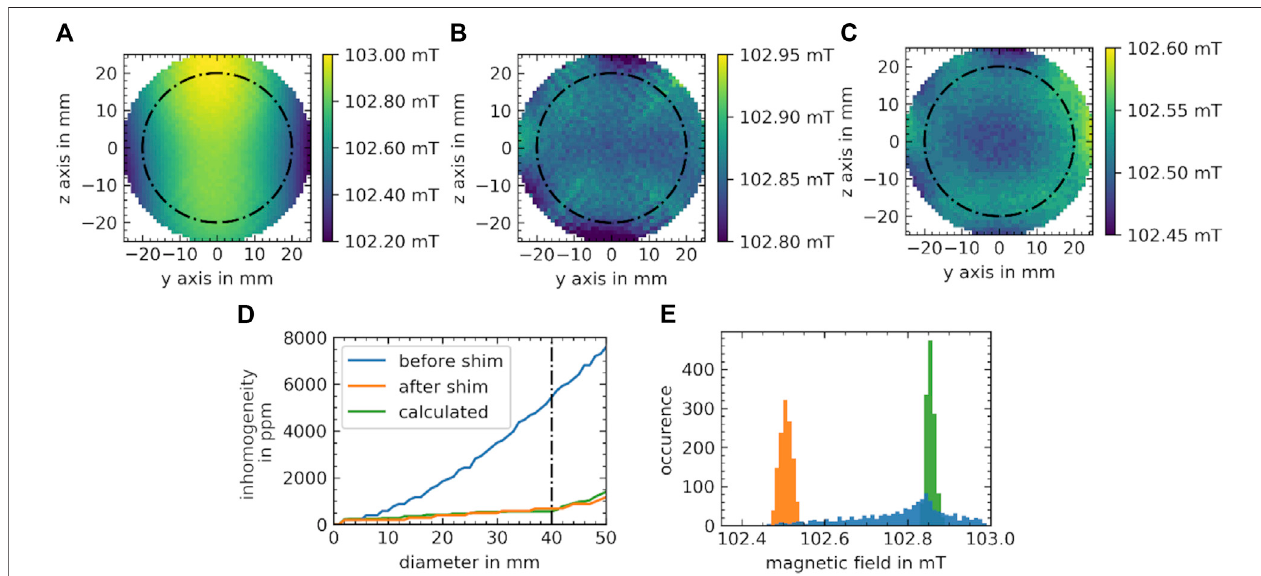
FIGURE 7 | Measured magnetic fi eld distributions before and after shimming on a two-dimensional target slice. (A) Measured fi eld distribution of the desktop MR magnet before shimming. (B) Predicted distribution calculated by the genetic algorithm with the dipole approximation. (C) Measurement after the implementation of the shim.Theblackdash-dottedlineindicatesthe4 cmtargetregion. (D) Fieldinhomogeneitiesoverdiameteroftheslicemeasuredbefore(blue)andaftertheshim(orange), together with the prediction of the shim, as calculated by the algorithm (green). (E) Occurrence of fi eld values measured before (blue) and after shimming (orange) and calculated (green) by the algorithm in the 4 cm target area (dash-dotted line in D) using the same colour representation as in